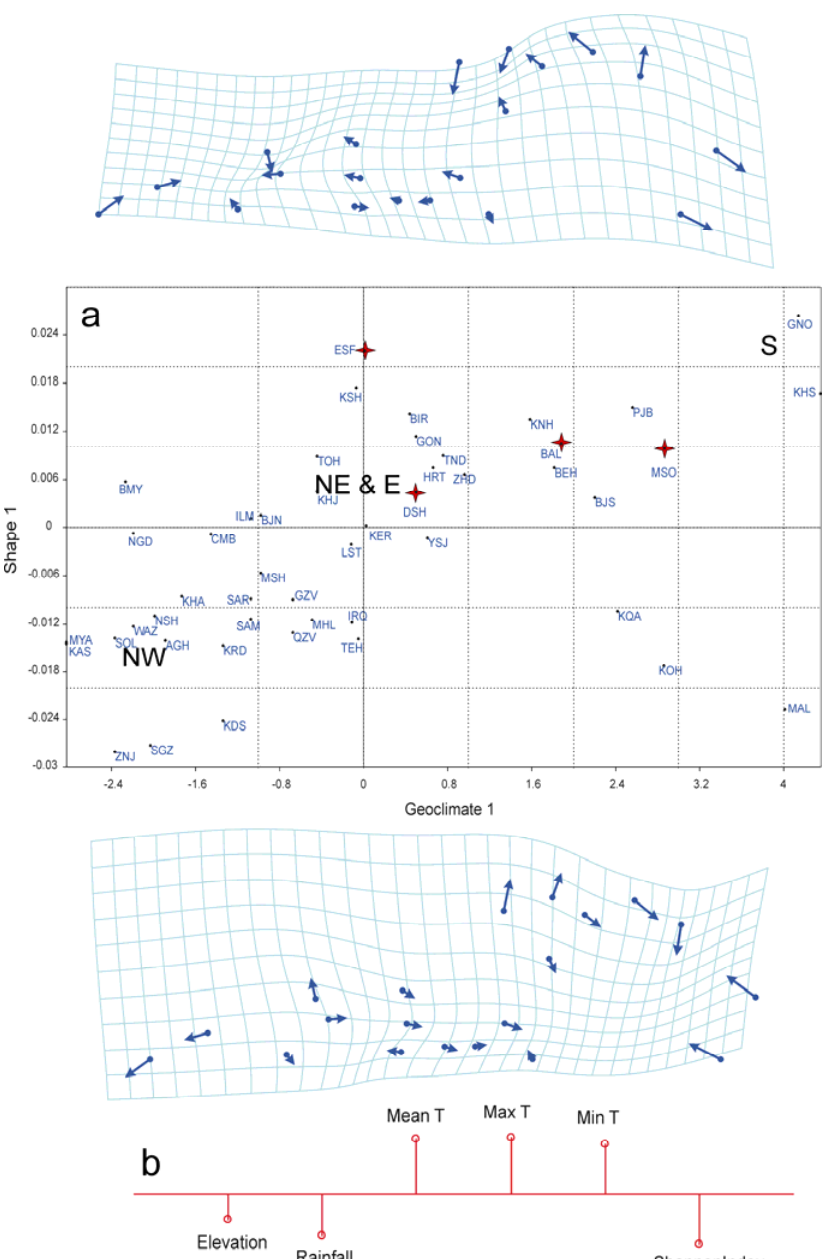
F IGURE 3. graphical representation of 2B-PLS results, based on the first paired vectors of shape and geoclimatical data (a) scatter plot showing the projections of the M. persicus populations onto the first shape and geoclimatical vectors; Grids: TPS deformations to the negative (bellow) and positive directions (above) respect to the consensus configuration. (b) variable profile plot for the geoclimatical variables. The orientation of the population from North Eastern Iran (NE), from Eastern Iran (E), from North Western Iran (NW) and from Southern Iran (S) is shown on the scatter plot. The type localities and the localities where the topotypes were collected from are shown by